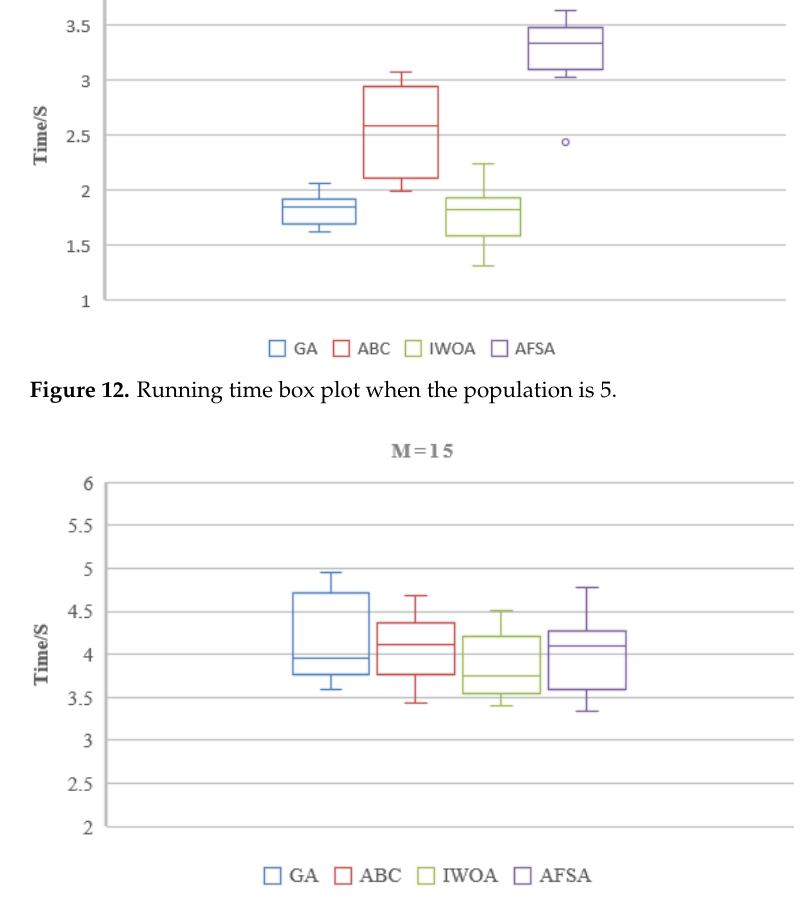
11 of 16 Figure 10. Box plot of run results when the population is 15.